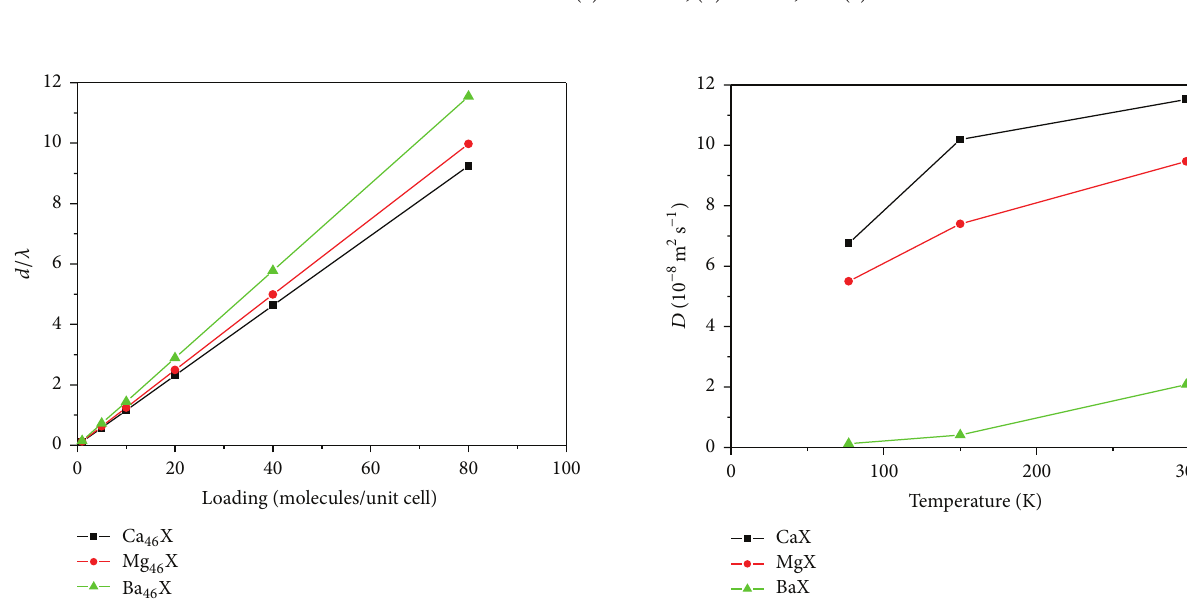
Figure 5: The dependence of 𝑑/𝜆 on the loadingsfor H 2 in Ca 46 X, Mg 46 X, and Ba 46 X zeolites at 77 K.